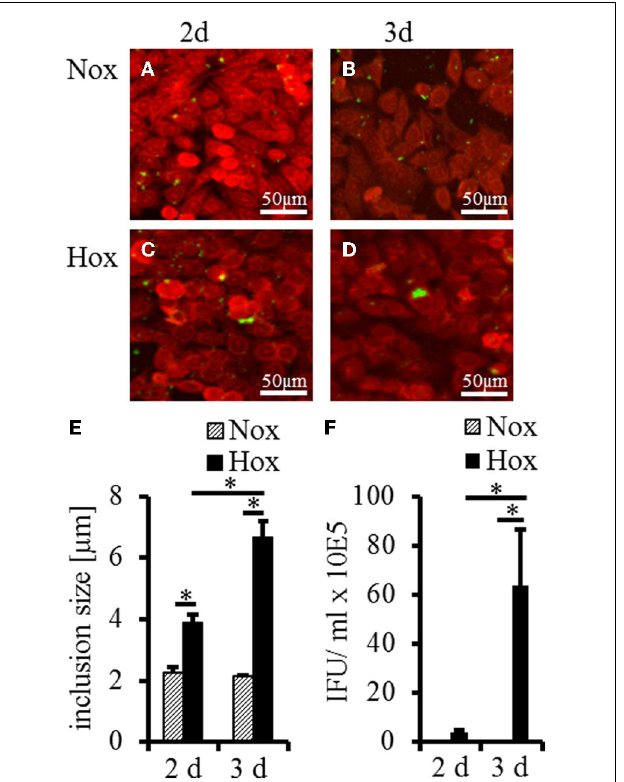
FIGURE 2 | Recovery analysis of IFN- γ treated C. trachomatis infected cells under normoxic and hypoxic conditions. Immunofluorescence staining shows reactivation of C. trachomatis (green) in HeLa-229 cells (red) under hypoxic (Hox) conditions (C,D) but not under normoxic (Nox) conditions (A,B) after 2 and 3 d, respectively. Quantitative analysis of the inclusion size showed significant larger inclusion after 2 and 3 d under hypoxic condition compared with normoxic condition (E) . Quantitative analysis of the infectious progeny of IFN- γ treated C. trachomatis after incubation for up to 3 d under normoxic and hypoxic conditions (F) ( n = 7, mean ± s.e.m., ∗ p ≤ 0 .